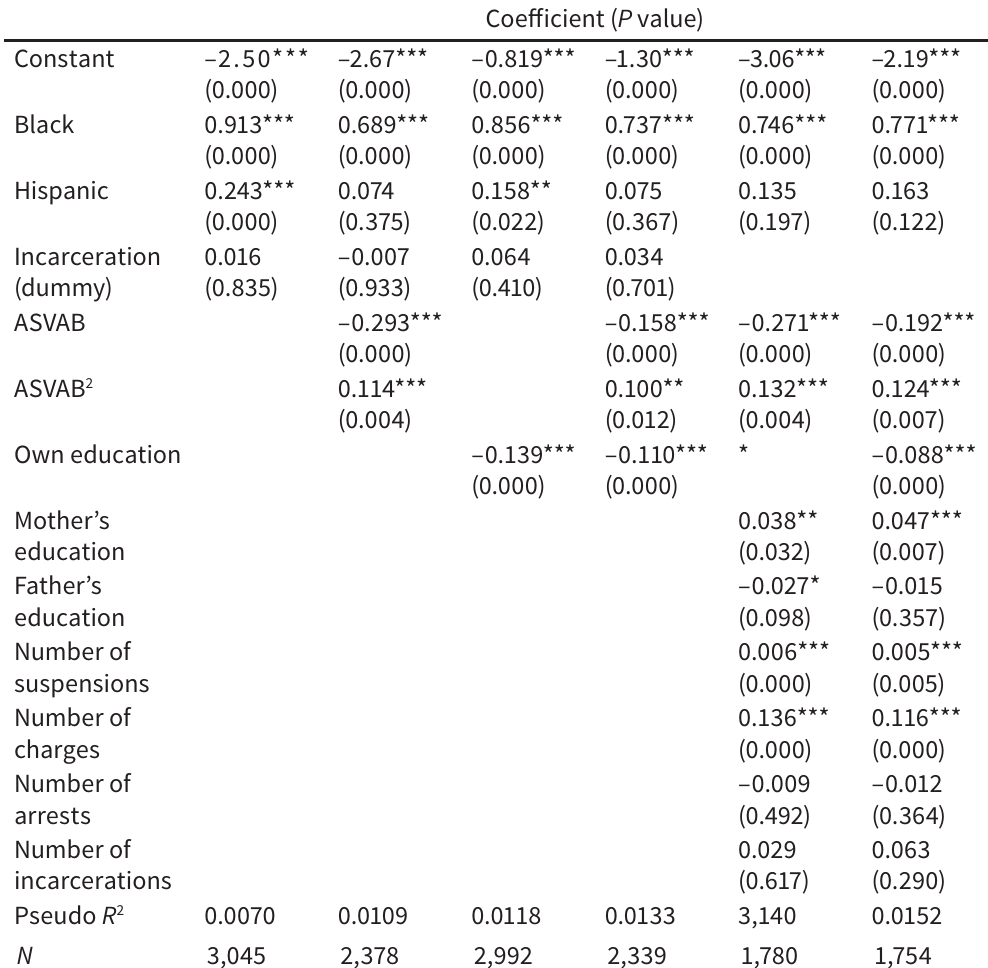
Negative binomial regression, weeks unemployed,